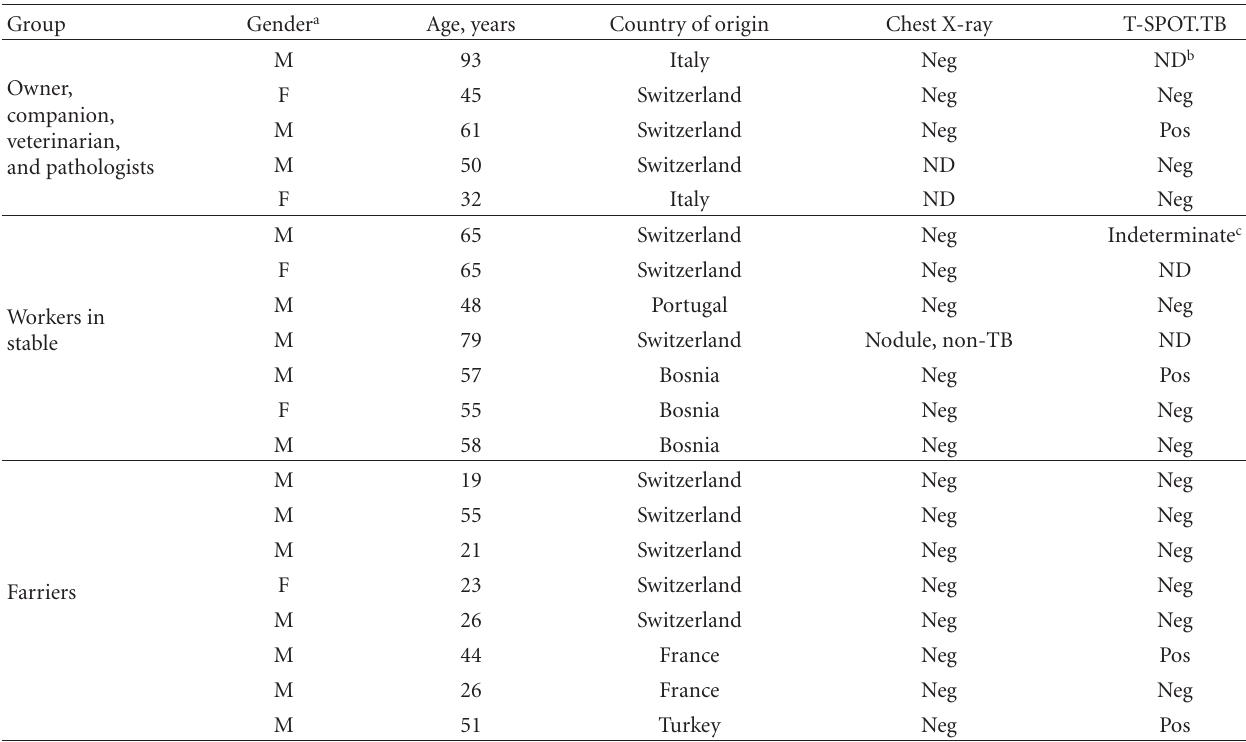
Table 1: Human contact testing